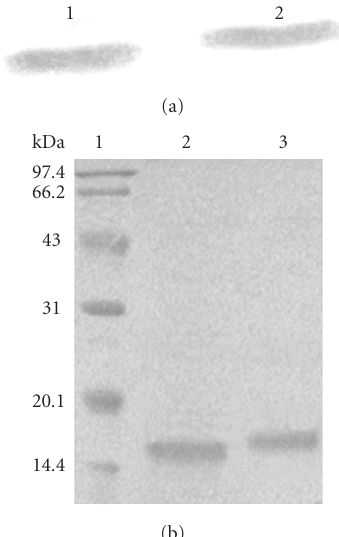
Figure 2: Western blot and SDS-PAGE analysis of the C tail- fused A box proteins. (a) Identification of the two fusion proteins expressed in E. coli DH5 α by western blot using a mouse anti- human HMGB1 monoclonal antibody directed against A box. Lane 1:A box+C tail; Lane 2:A box+(Gly 4 Ser) 3 +C tail. (b) Purity analysis of the two fusion proteins by SDS-PAGE. After purification by Ni 2+ -NTA chromatography, the purities of the two fusion proteins were analyzed with SDS-PAGE. Equal amounts of purity proteins (10 μ g) were loaded in Figure 2(b), separated by 12% PAGE gel electrophoresis. Lane 1:Molecular weight standards; Lane 2:A box+C tail; Lane 3:A box+(Gly 4 Ser) 3 +C